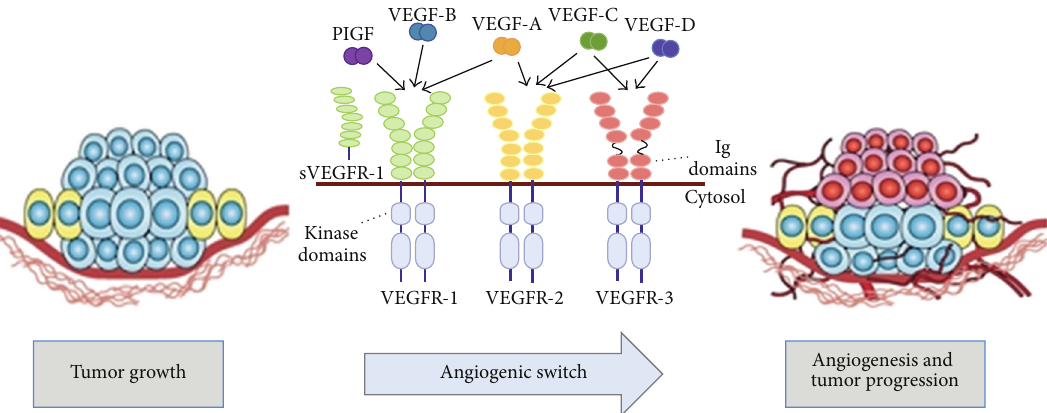
Figure 1: Angiogenesis promotes cancer growth and metastasis. Angiogenesis, the process of developing new blood vessels from preexisting vascular networks, is a well-described mechanism leading to the initiation and maintenance of tumours and the promotion of metastasis at secondary sites. The vascular endothelial growth factor (VEGF) family of ligands and receptors mainly includes VEGF-A, VEGF-B, VEGF-C, VEGF-D, placental derived growth factor (PlGF), VEGFR-1, VEGFR-2, and VEGFR-3. The best characterized of the VEGF family members is VEGF-A, whose binding to VEGFR-2 (FLK1) is the predominant mechanism through which tumour cells promote the so-called angiogenic